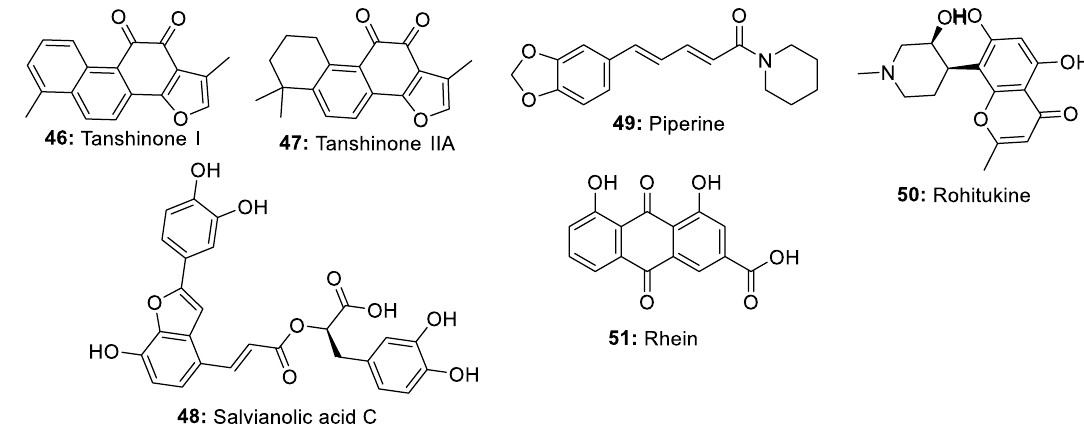
Fig. 2 Plant anti-inflammatory metabolites also produced by endophytic